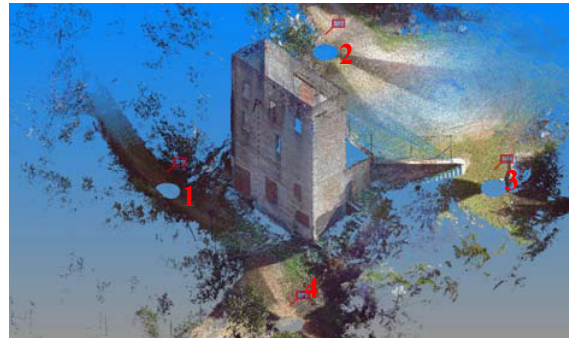
Figure 4: TLS station points